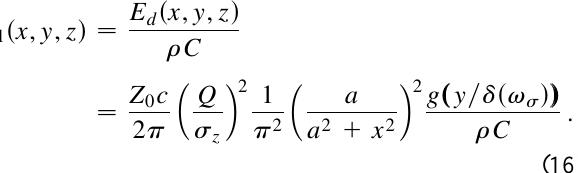
FIG. 6. Electron beam running into a metal